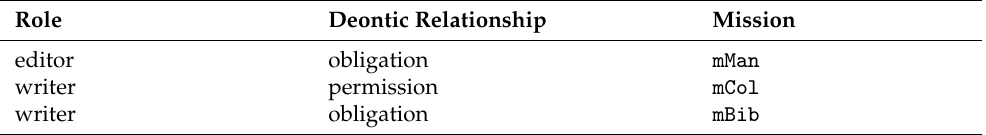
Table 2. Deontic specification for a Writing Paper scenario, based on [52].